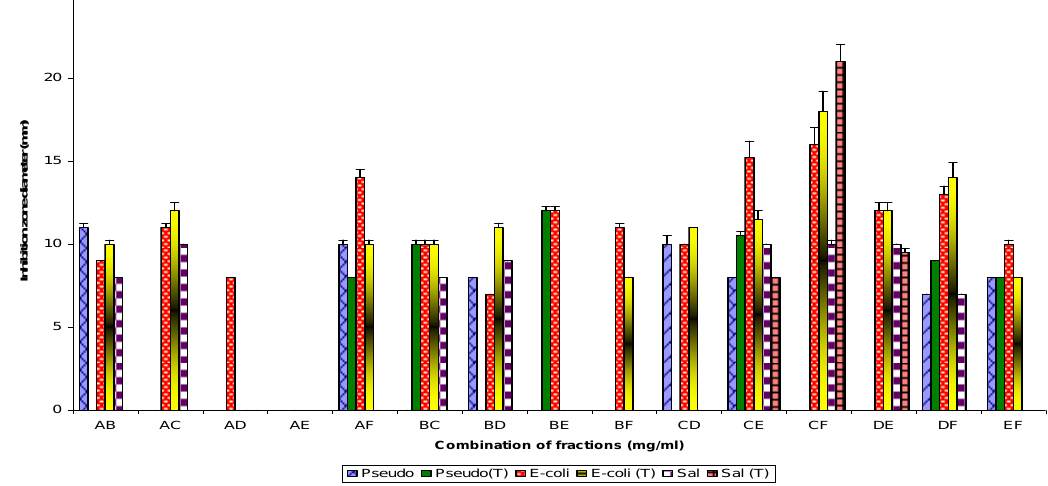
Figure 1. Antibacterial susceptibility pattern of the Gram negative bacterial test strains to combination of fractions Ti